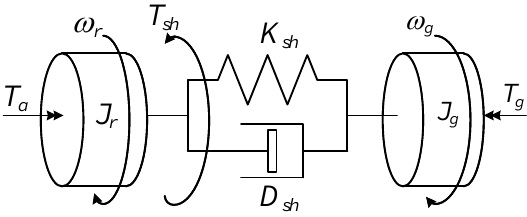
Figure 1. Two-inertia model of the